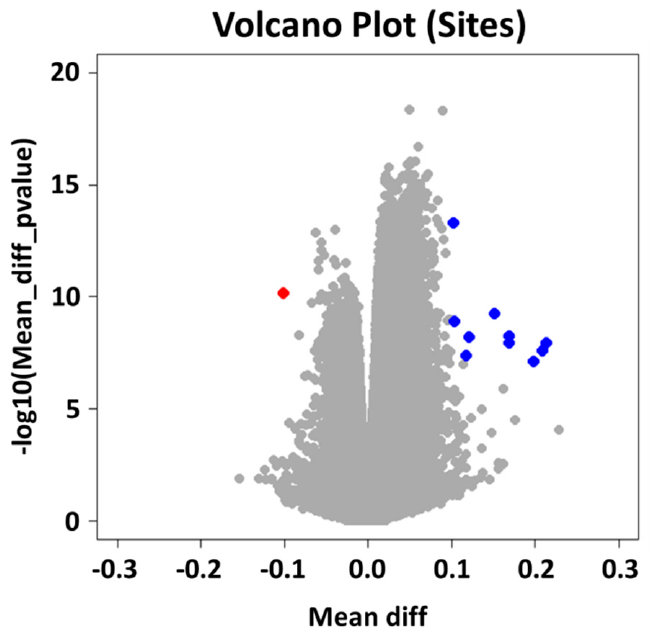
Figure 2. Volcano plot for differential methylation: CpG sites meeting p -value and methylation difference thresholds are depicted as red (hypo-methylated) and blue (hyper-methylated) dots.